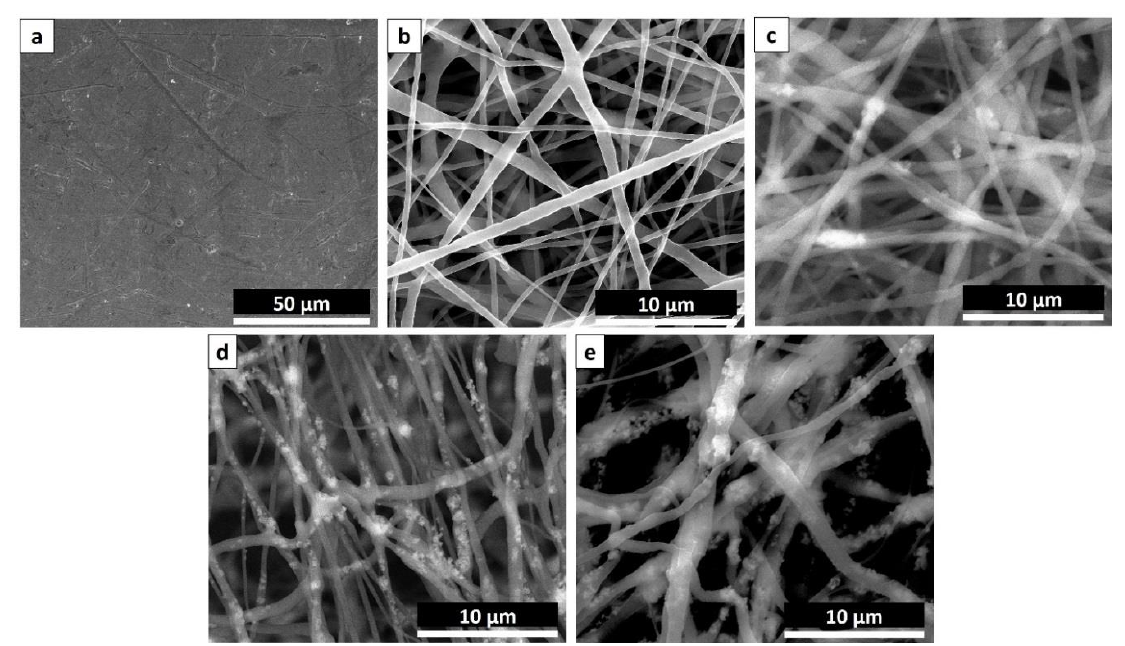
Figure 1. SEM Images displaying ( a ) cpTi substrate; PCL mat containing ( b ) 0 wt % TiO 2 , ( c ) 3 wt % TiO 2 , ( d ) 5 wt % TiO 2 , and ( e ) 7 wt % TiO 2 .